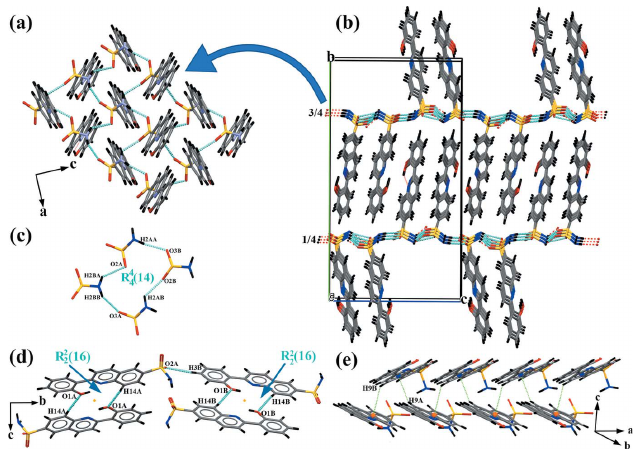
Figure 3 Part of the crystal structure of the compound (I) showing ( a ) a view along the b axis of the two-dimensional hydrogen-bonded network; ( b ) the two- dimensional network parallel to the ac plane at 1/4 and 3/4 of the b- axis length; ( c ) the N—H (cid:3)(cid:3)(cid:3) O hydrogen bonds of the sulfonamide groups generating an R 4 (14) motif; ( d ) C—H (cid:3)(cid:3)(cid:3) O hydrogen bonds generating an 4 inversion dimer with an R 2 (16) ring motif and ( e ) the C—H (cid:3)(cid:3)(cid:3) (cid:2) 2 interaction generating a chain running along the a- axis direction.